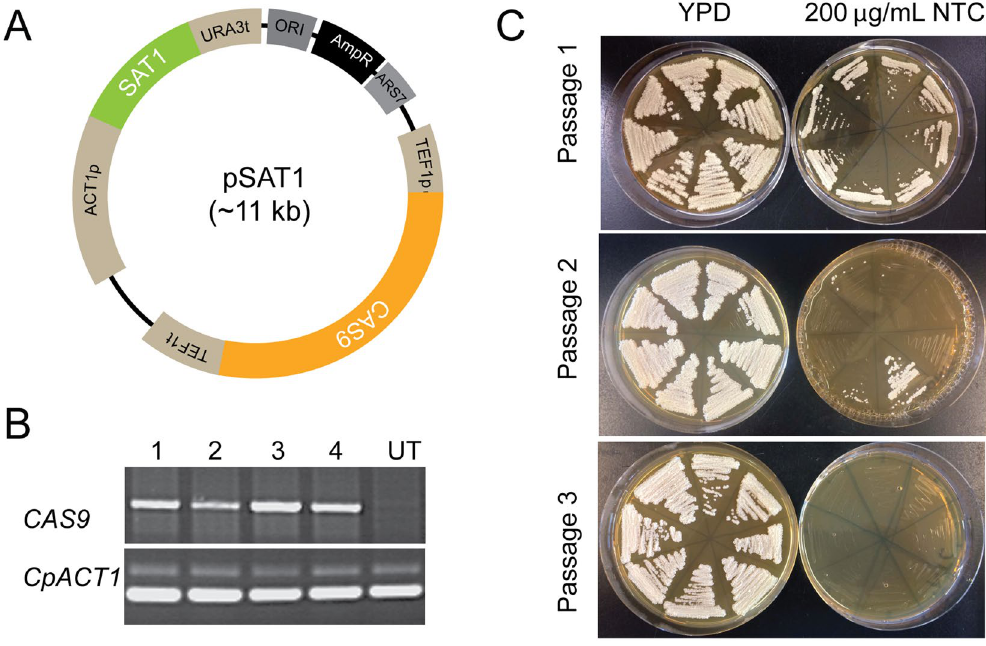
Figure 1. Autonomously replicating plasmids in C . parapsilosis . ( A ) pSAT1 was constructed by cloning a codon-optimized version of CAS9 between the promoter and terminator sequences of TEF1 from C . parapsilosis in a pUC57-based plasmid. SAT1 (nourseothricin resistance) expressed from the C . albicans ACT1 promoter was isolated from pSFS2A 58 , and ARS7 , an autonomously replicating sequence from C . parapsilosis 43 , was isolated from pGIZI. ( B ) CAS9 is expressed in C . parapsilosis cells transformed with pSAT1. RNA was isolated from four transformants and from one untransformed culture (UT). Expression of CAS9 and ACT1 was measured by RT-PCR. ( C ) pSAT1 is easily lost. Transformed cells were patched to YPD plates without nourseothricin (NTC) for 48 h, and then streaked on YPD and YPD + NTC. Colonies from YPD were repatched after 48 hr. All transformants lost nourseothricin resistance after just two